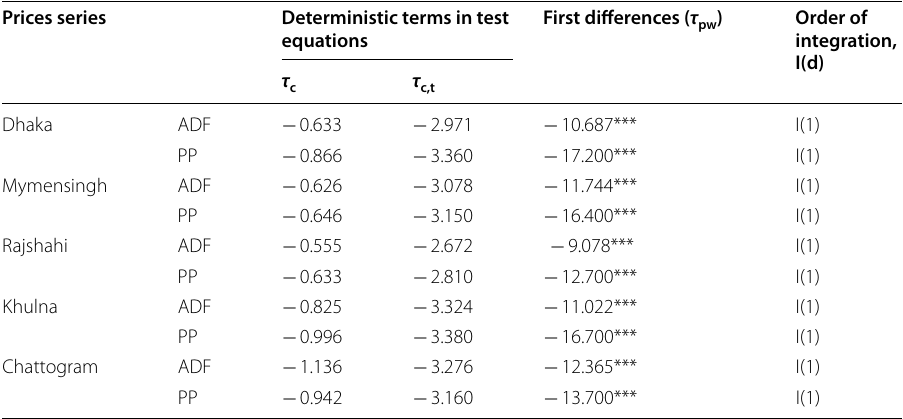
Table 2 Unit root test